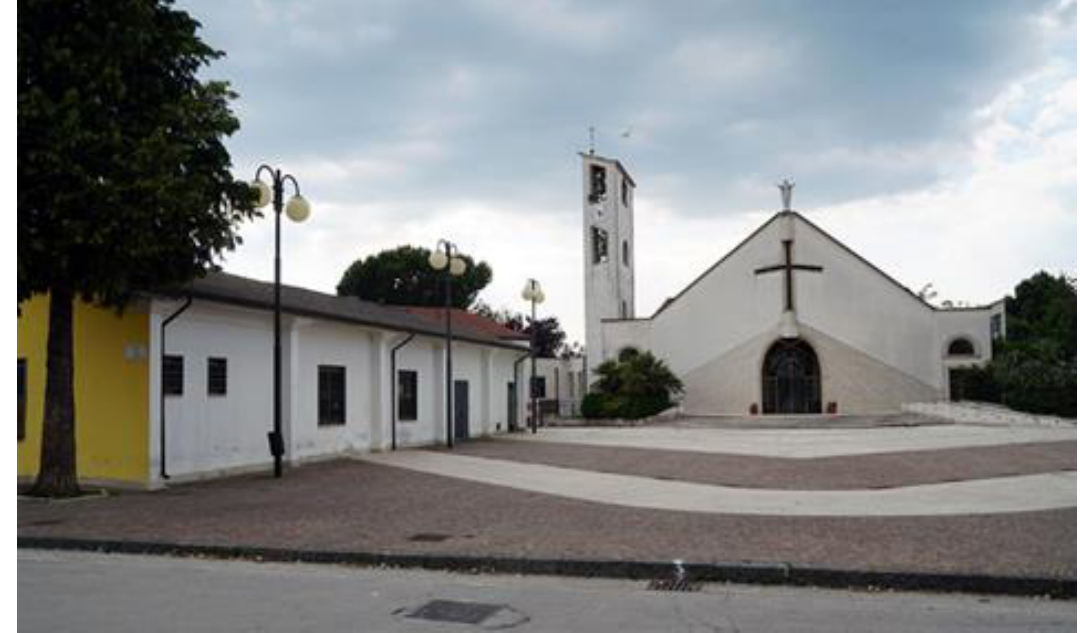
Figure 63. San Michele di Serino: the new Church of San Michele Arcangelo (photos by [35,36]).